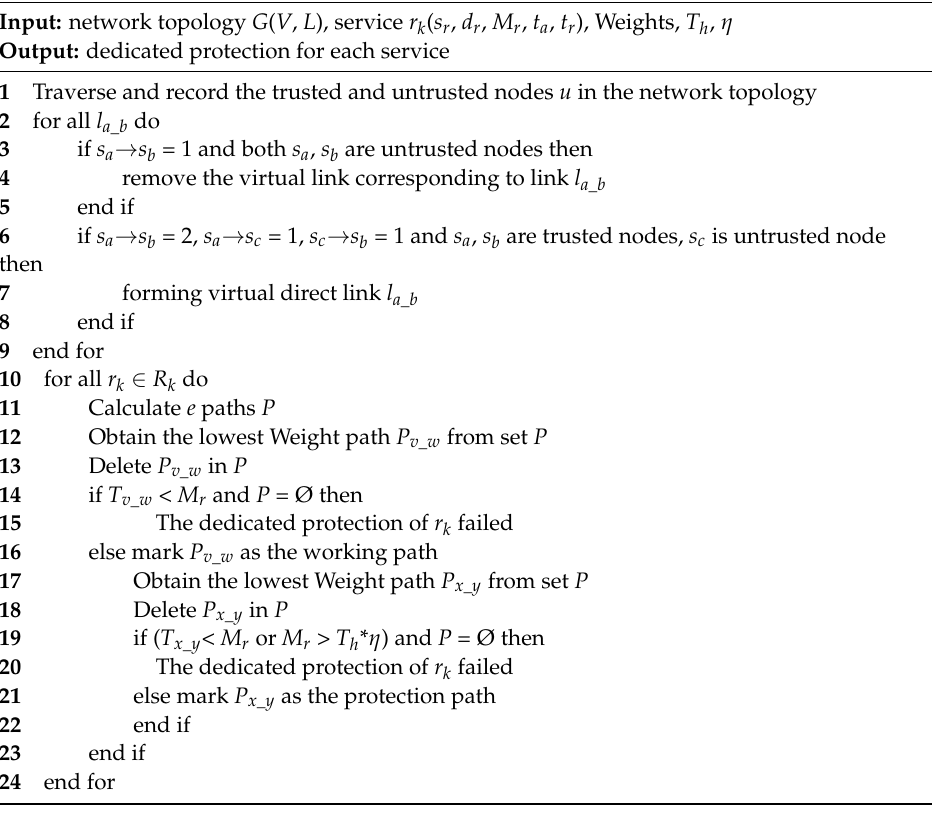
Algorithm 1. Topology-abstraction-based protection scheme in QKDN with partially trusted